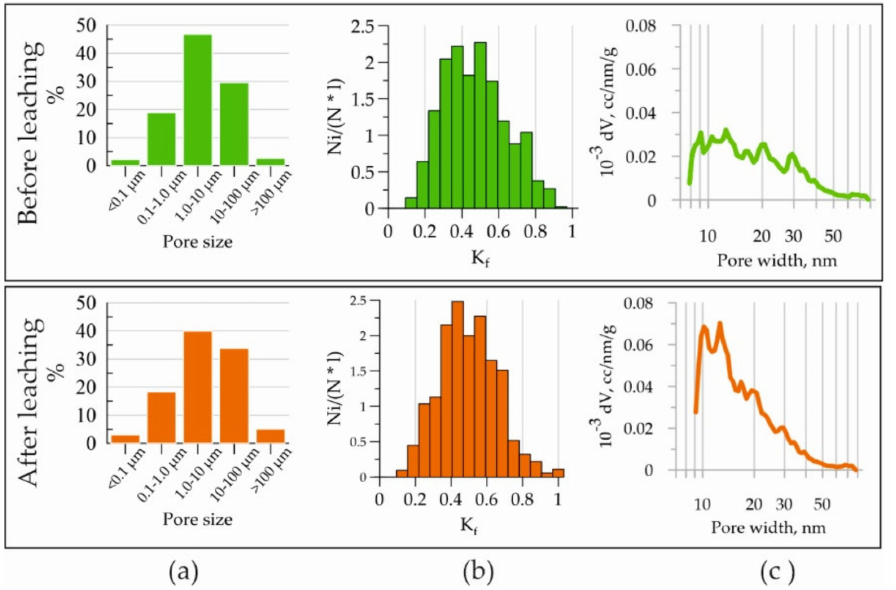
Figure 3. The change in the porosity of concrete samples. ( a ) Histogram of pore size distribution obtained from SEM image analysis. ( b ) Dependence of the probability density of distribution on the pore shape coefficient. K f is the degree of roundness, with 1 being isometric round pores and 0.01 being strongly elongated—elements obtained from SEM image analysis. ( c ) Change in the pore distribution of concrete obtained from nitrogen